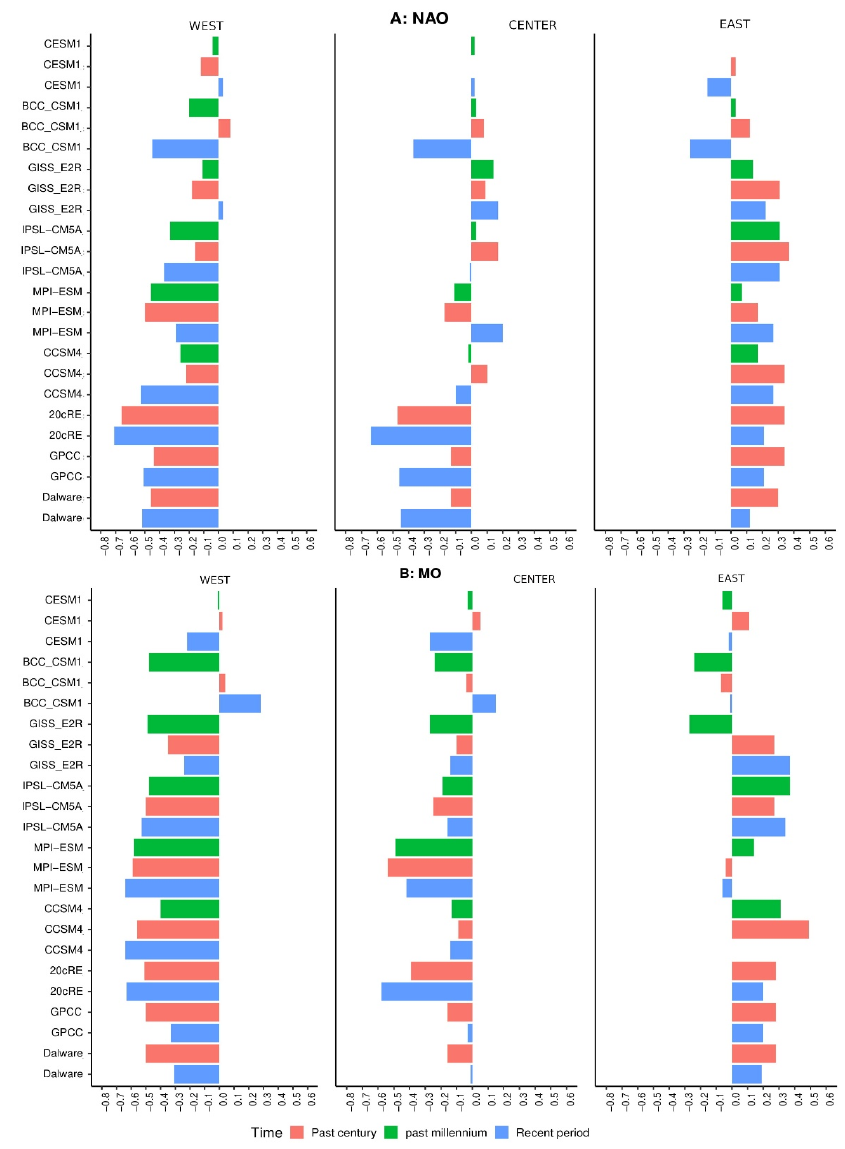
Figure 6. Pearson’s correlation coefficients between winter precipitation (observations, reanalysis, and CMIP5 simulations) and (A) NAO and (B) MO indices for western, central, and eastern North Africa during the recent period (1979–2005), the past century (1850–2005), and the past millennium